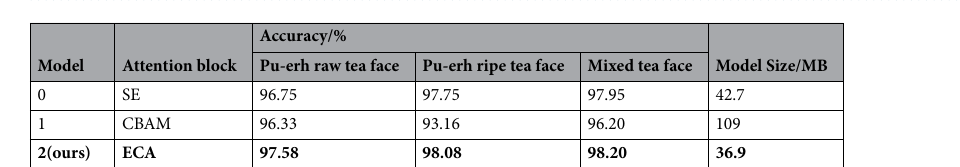
Figure 15. ( a ) ROC curve for raw tea face dataset; ( b ) ROC curve for ripe tea face dataset; ( c ) ROC curve for mixed tea face dataset.